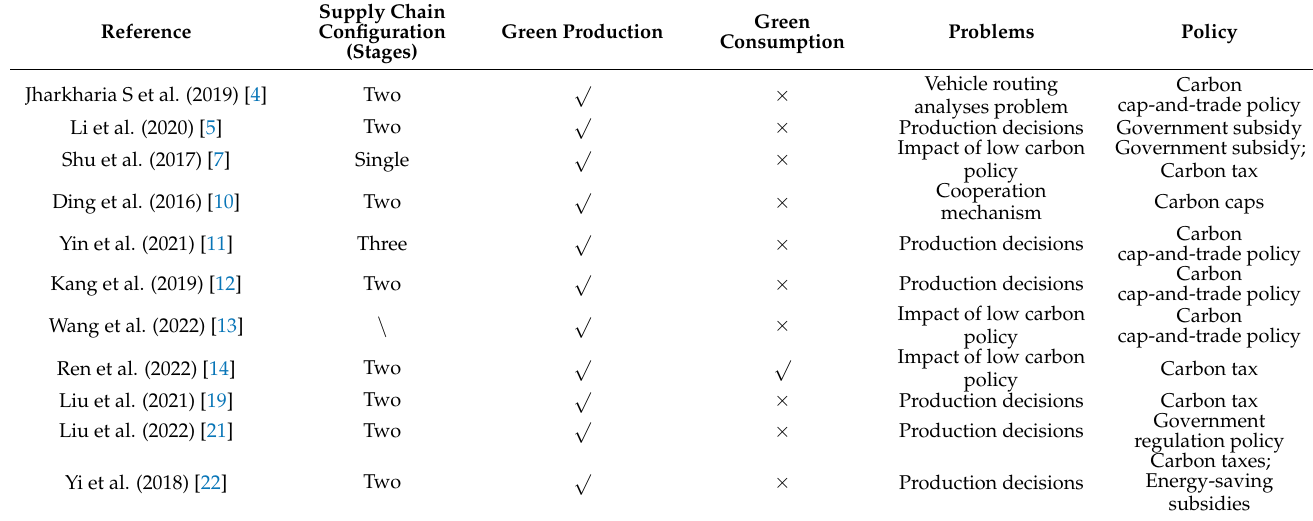
Table 1. Comparison of this paper with existing related